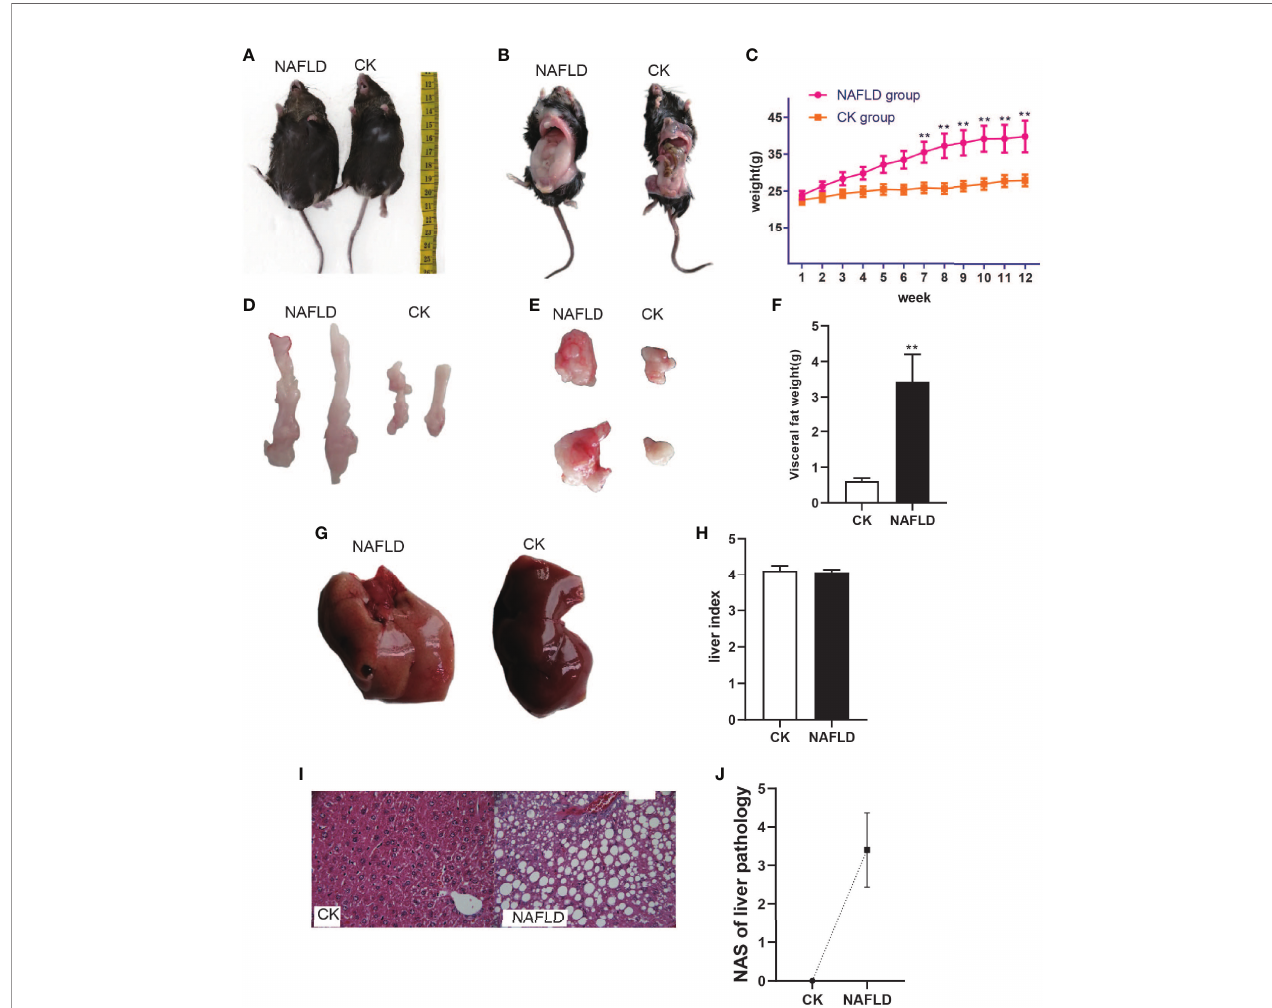
FIGURE 1 | The body weight, fat mass, liver weight and Histopathology with CK and NAFLD mice, CK mice were fed Standard chow diet, NAFLD mice were fed HFD. (A, B) Representative pictures of CK and NAFLD mice, showing enormous discrepancy in body size. (C) Body weight changes in ND or HFD fed mice over 12 weeks. From week 7, the body weight of NAFLD group was signi fi cantly higher than CK group. (D, E) Representative pictures of perirenal fat and epididymal pad fat showing the difference of fat size between NAFLD mice and Control mice. (F) Tissue weight of perirenal fat and epididymal fat pads after 12 weeks of treatment. (G) Gross appearance of the liver. The liver of NAFLD mice was khaki yellow and that of normal mice was dark red. (H) There were no signi fi cant differences in liver index (% of body weight) between the groups. (I) Hematoxylin and eosin (H&E) staining of liver (400×), hepatocyte steatosis was obvious in NAFLD mice. (J) Through the NAS scoring system, the NAS score is 3.4, indicating moderate NAFLD. “ ** ” indicated p-value < 0.01 (students t